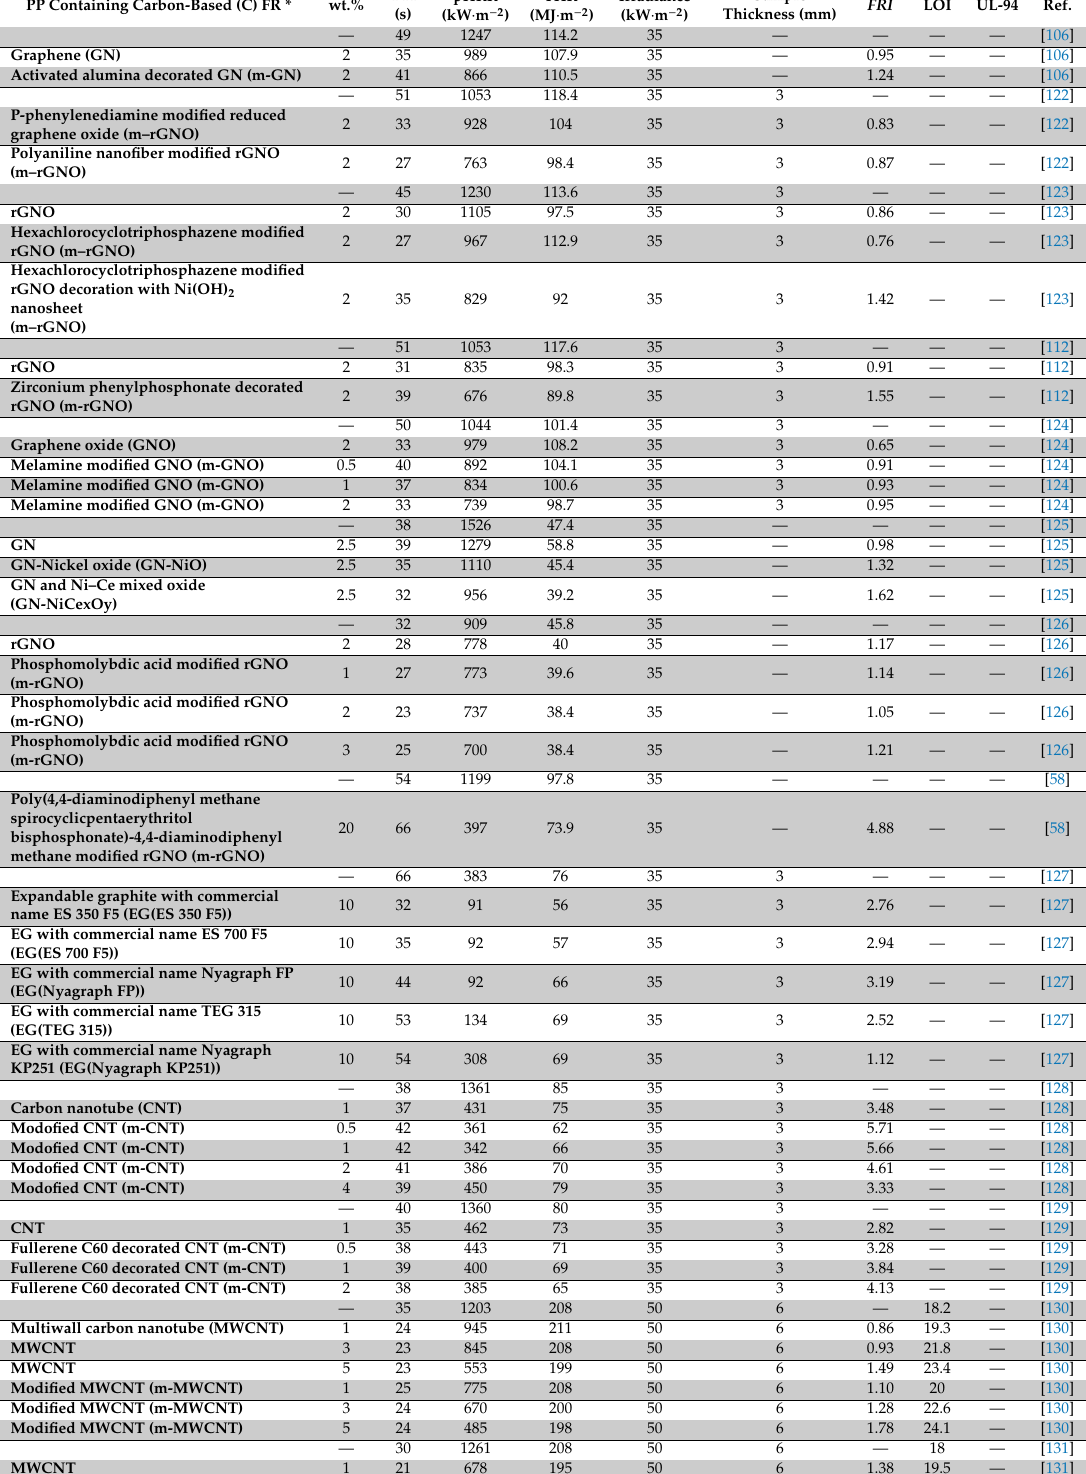
Table 4. Flame-retardant PP materials containing carbon-based (C) flame retardants. Data are extracted from the literature: cone calorimetry parameters (TTI, pHRR, THR), LOI, and UL-94 values. The FRI values were calculated by authors of the present review. The name and the percentage of flame retardants are provided in separate columns. “wt.%” was used for loading level of additives, while “—” stands for the systems free of additive or the neat PP. * FR means flame retardant. Since all comparisons were made in terms of FRI , classification of polymers in terms of their flame-retardant properties was not surveyed based on the chemistry of additives, heat flux, sample thickness,